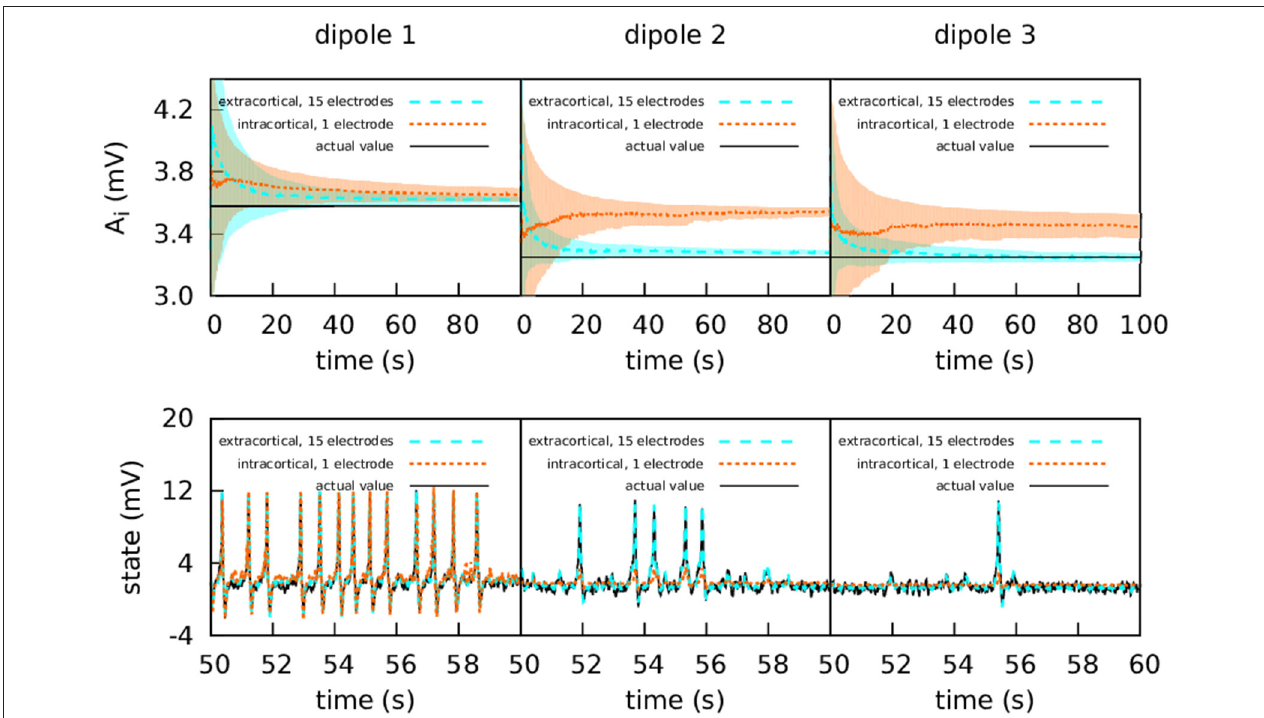
FIGURE 3 | Intracranial and extracranial fittings with propagated excitation along unidirectionally coupled cortical columns. The upper panels show the estimation of parameter A , and the lower panels show the estimations of the observed states. The lines show the averages of the 50 realisations of the estimation, and the shadowed areas indicate the standard deviation. The actual values of the A parameters are A 1 being set to standard values ( Table 1 ). All three cortical columns received an external input, p ( t ), with p 0 k 10. The measurements were corrupted with Gaussian noise of mean 0 and standard deviation 100 mV for extracranial measurements and standard deviation = 5 mV for intracortical measurements. Except for cortical column 1, with intracortical data the filter converges to a much higher value than the target, whereas with extracranial data the filter converges to a value which is accurate. In the lower panels it is shown that extracranial estimations of the state are also accurate, whereas intracortical estimations fail to reproduce the spikes